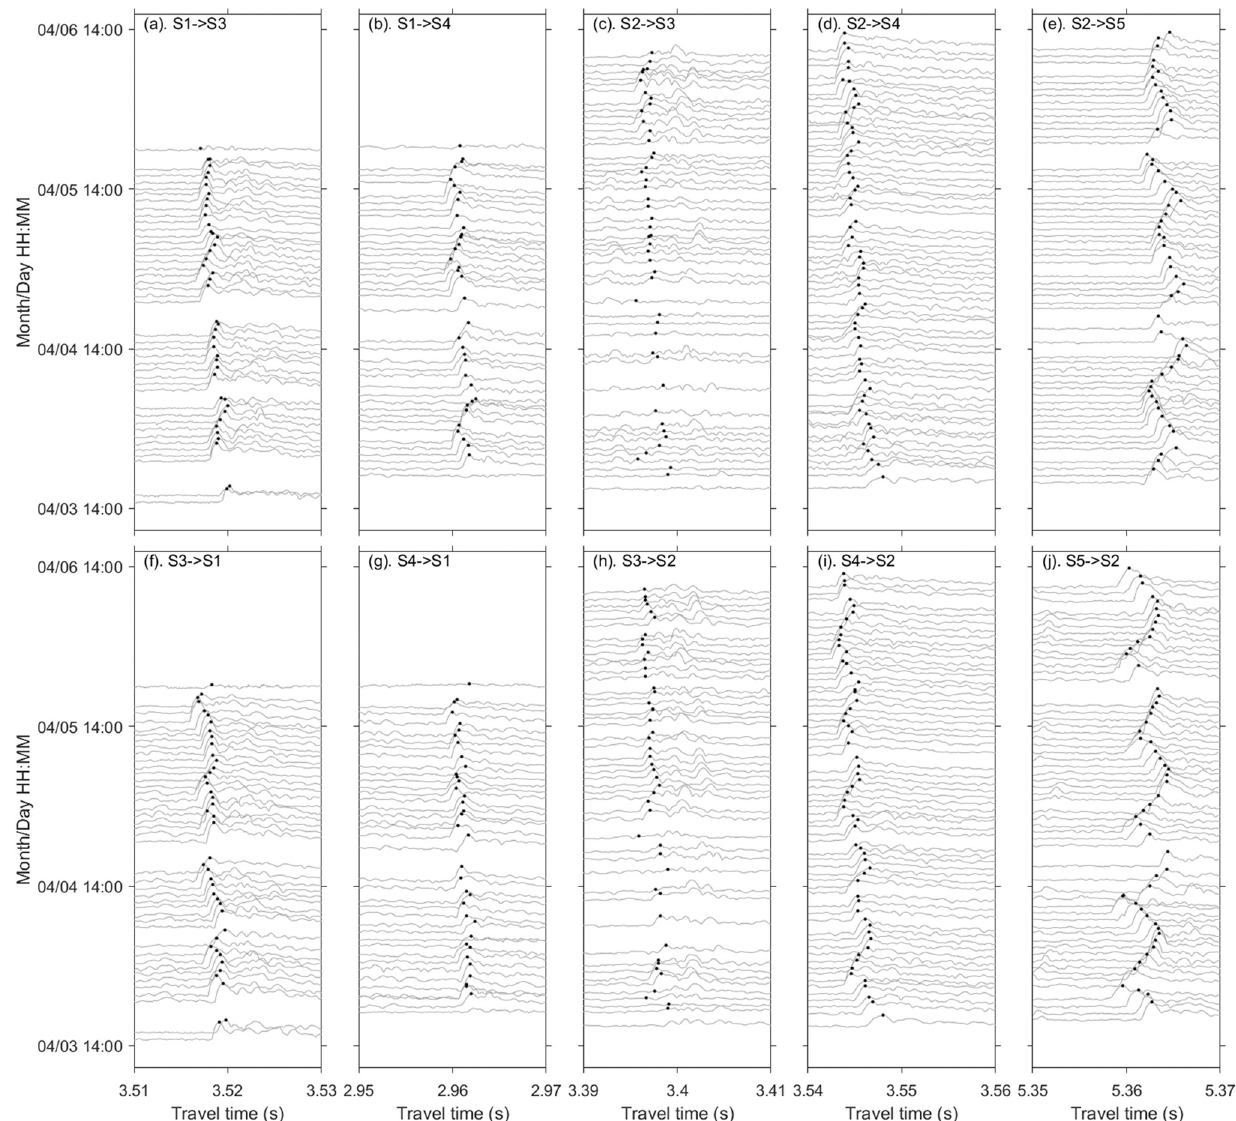
Figure 2. Stack diagrams (gray lines) constructed by the 10 min interval reciprocal correlation patterns for the transmission paths S1S3 ( a ), S1S4 ( b ), S2S3 ( c ), S2S4 ( d ), S2S5 ( e ), S3S1 ( f ), S4S1 ( g ), S3S2 ( h ), S4S2 ( i ), and S5S2 ( j ). The first arrival peaks are indicated with black dots.